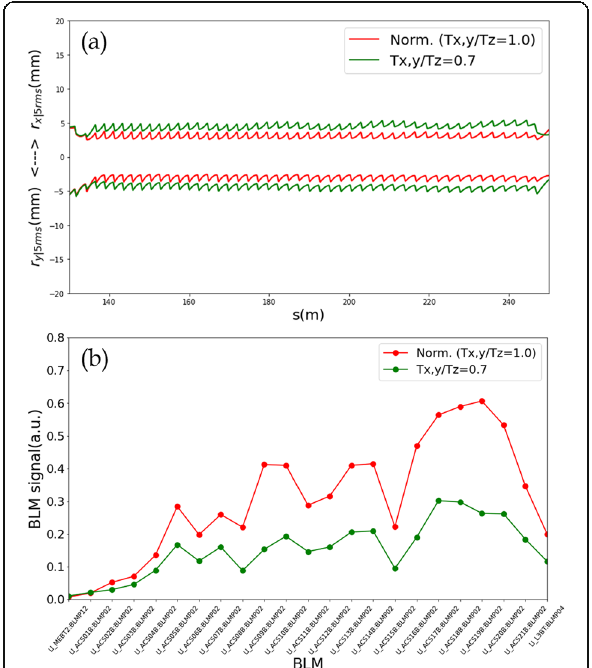
Fig. 9 a Simulation results for the J-PARC linac; beam envelopes along the ACS linac section. b Experimental results at the J-PARC linac; beam loss monitor signals along the ACS linac section. The red curves show the results with the original quadrupole setting, while the green ones represent the cases with the 25% weaker quadrupole strengths [20]